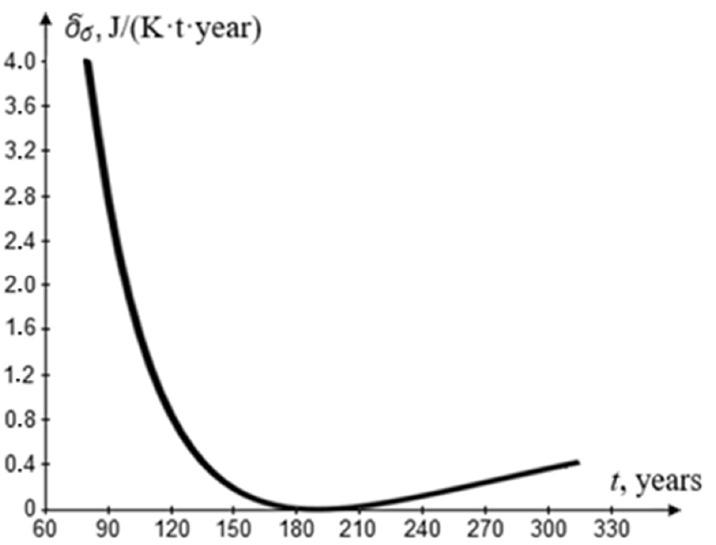
Figure 2. Dependence of effective specific entropy production on time for a two-species forest stand. The Y-axis shows the values of effective specific entropy production in J/(K t year). On the X-axis is time in years.